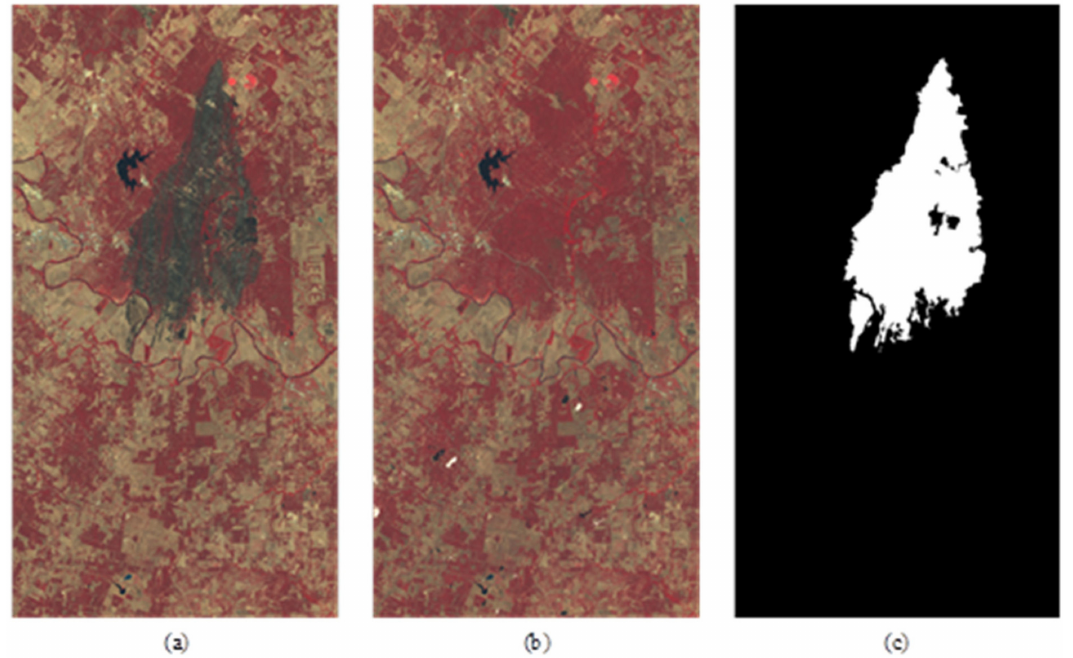
Figure 4. ( a ) Image of August, ( b ) image of September, and ( c ) reference